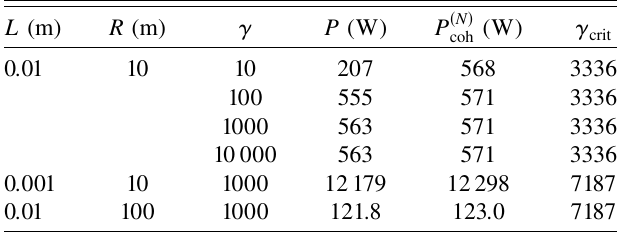
TABLE I. Coherent power, as calculated by self-force P and . as by Schwinger from far fields, P (cid:2) N (cid:3) coh